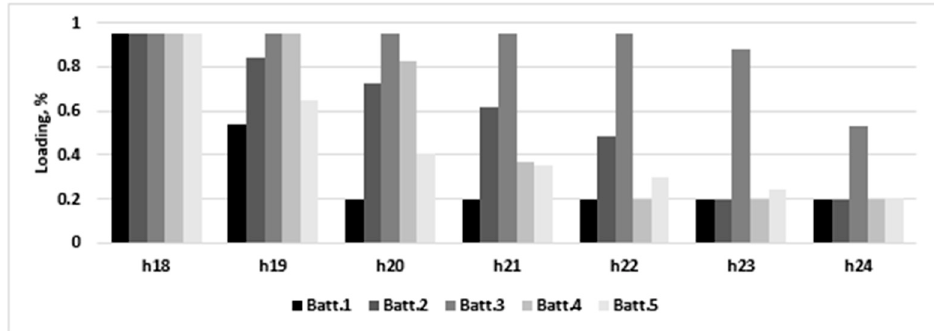
Figure 10. The discharge pattern for the batteries, Scenario 2.